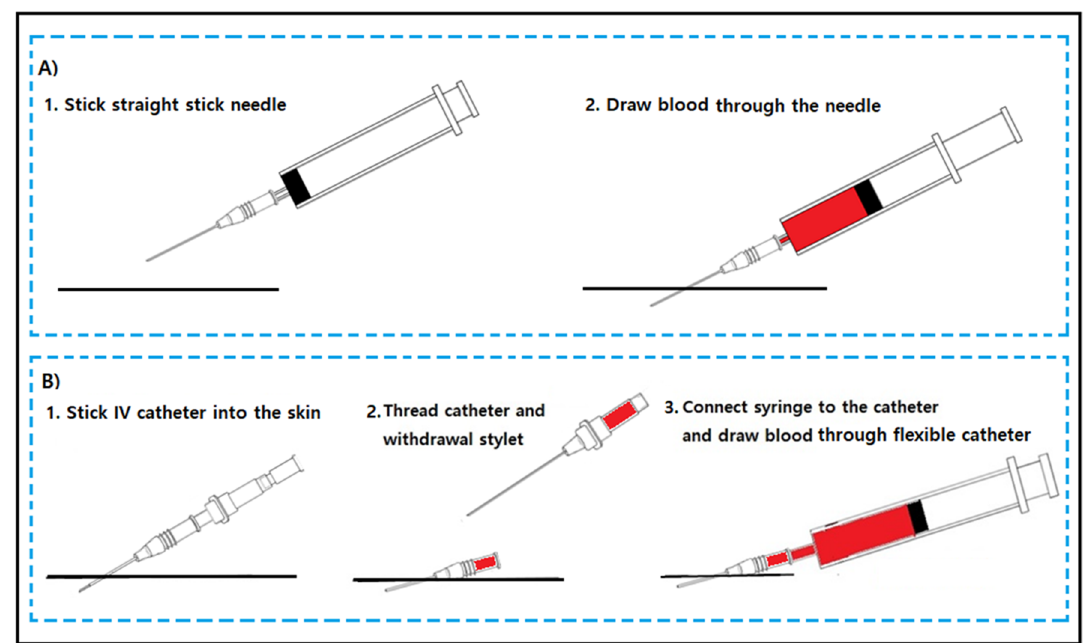
Figure 1. The standard blood collection method ( A ) and the conventional blood collection method in EDs ( B ).